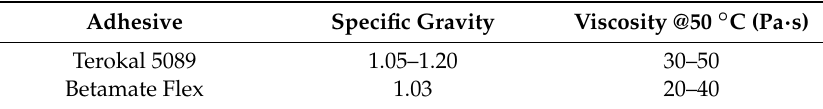
Table 2. Material properties of two adhesives used in this